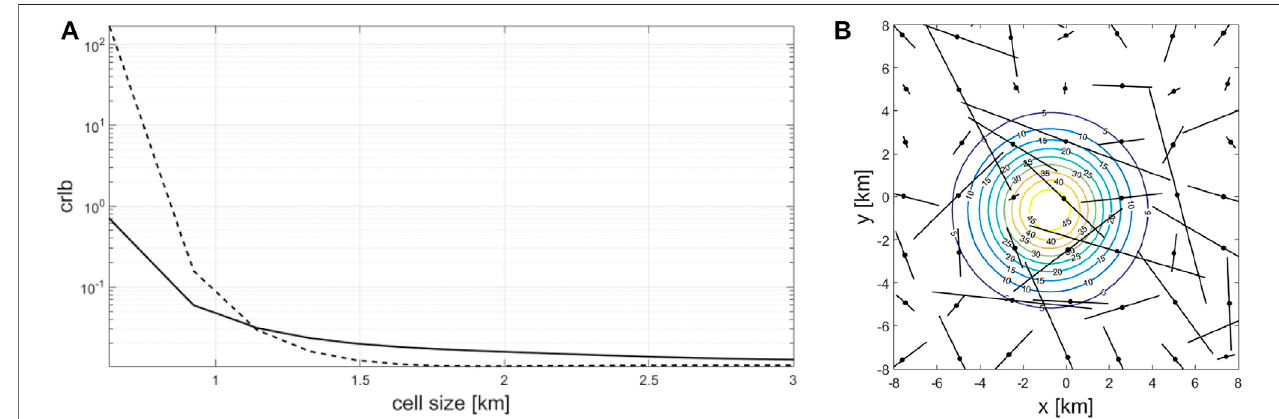
FIGURE3| FromGatandMesser(2019) — (B) anexampleoftheassumedraincellandnetworkofground-level sensors. (A) TheCramér – Raolowerbound (noted inthis fi gureascrlb)onthespatialmeansquareerror(MSE) overtheentirerainmapfordifferentsizesoftheraincells.Solidline — allsensorsarelinesensors(CMLs) — for example, the lines on (B) ; dashed lines — all sensors are point sensors (RGs) — for example, the points on (B) .